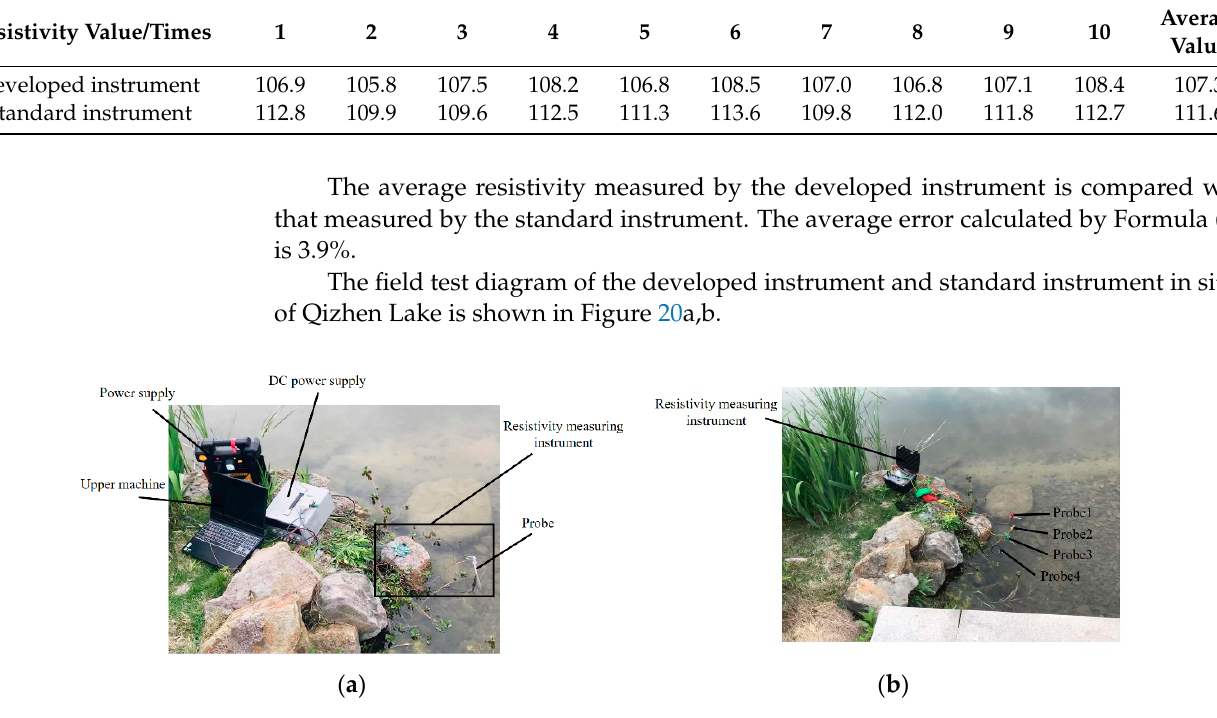
Figure 20. Site 2 of Qizhen Lake developed instrument ( a ) standard instrument; ( b ) field test diagram (unit: Ω · m). The resistivity and average values measured by developed and standard measuring instruments at Site 2 of Qizhen Lake are shown in Table 5 below. Table 5. The resistivity and average values measured by developed and standard measuring instruments at Site 2 of Qizhen